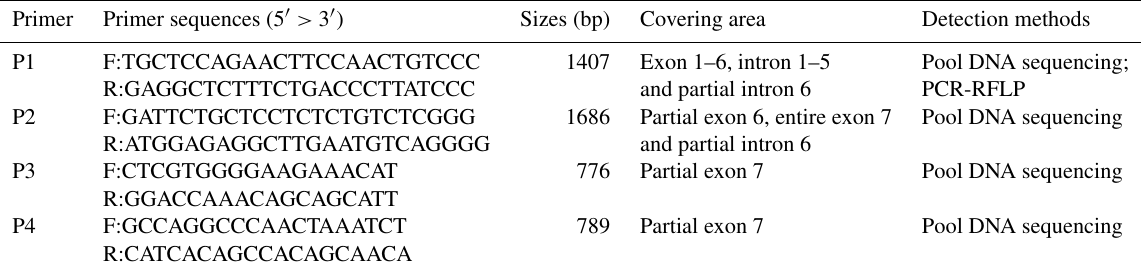
Table 1. Amplification PCR primer sequences of the pig TMEM95 gene. Primer Primer sequences (5 (cid:48) > 3 (cid:48) ) Sizes (bp) Covering